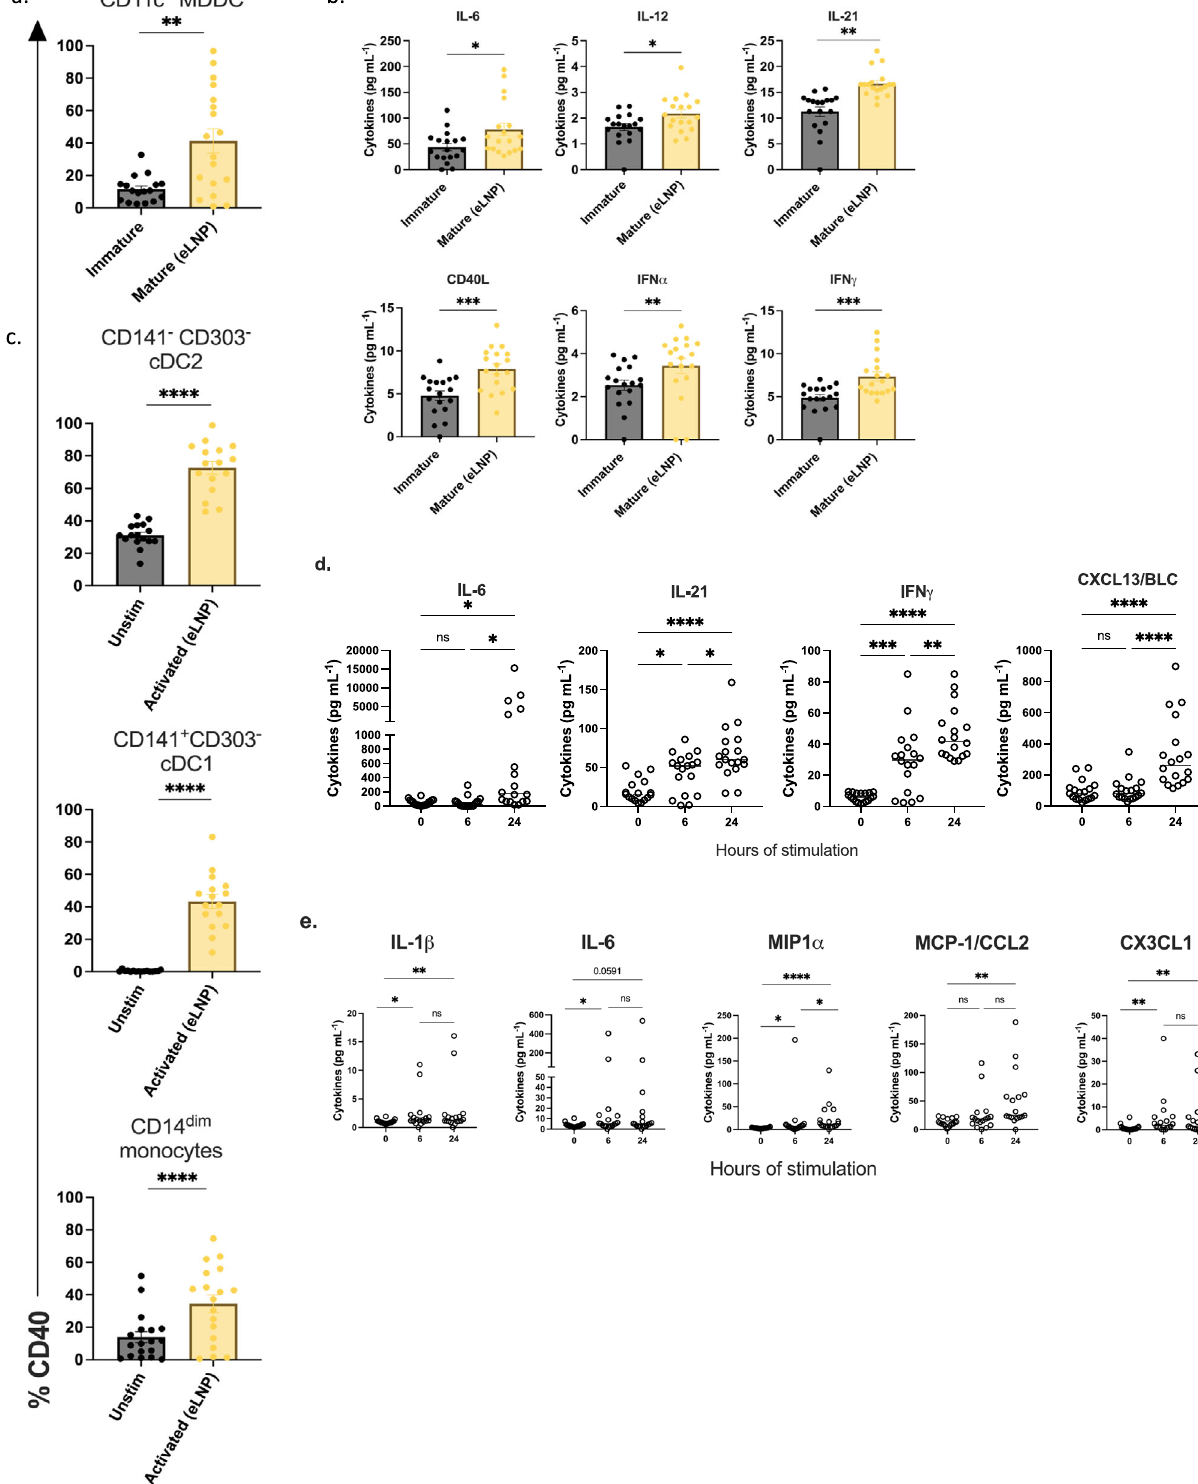
Fig. 1 eLNP treatment promotes robust innate immune response and maturation. a Activation status of monocyte-derived DCs as measured by CD40 expression after 24 h of 15 μ g/mL (total lipids, or~7.5 μ g/mL ionizable lipid) empty LNP (eLNP) stimulation (yellow). n = 18. b Innate cell cytokine expression after 24 h eLNP stimulation (yellow) compared to that in unstimulated (media) cells (grey) of MDDCs. n = 18 for each group as measured by Luminex. c Activation status of DC and monocyte subsets from PBMCS as measured by CD40 expression after 24 h of eLNP stimulation (yellow). n = 18. d Dynamics of cytokines from PBMCS at 0, 6, and 24 h after eLNP stimulation. n = 18 as measured by Luminex. e Dynamics of cytokines from monocytes at 0, 6, and 24 h after eLNP stimulation. n = 18 as measured by Luminex. Each individual circle represents one individual subject. Data was analyzed either using non-parametric Mann Whitney T-test or by one-way ANOVA followed by Tukey ’ s test. * P < 0.05, ** P < 0.01, *** P < 0.001, **** P < 0.0001.